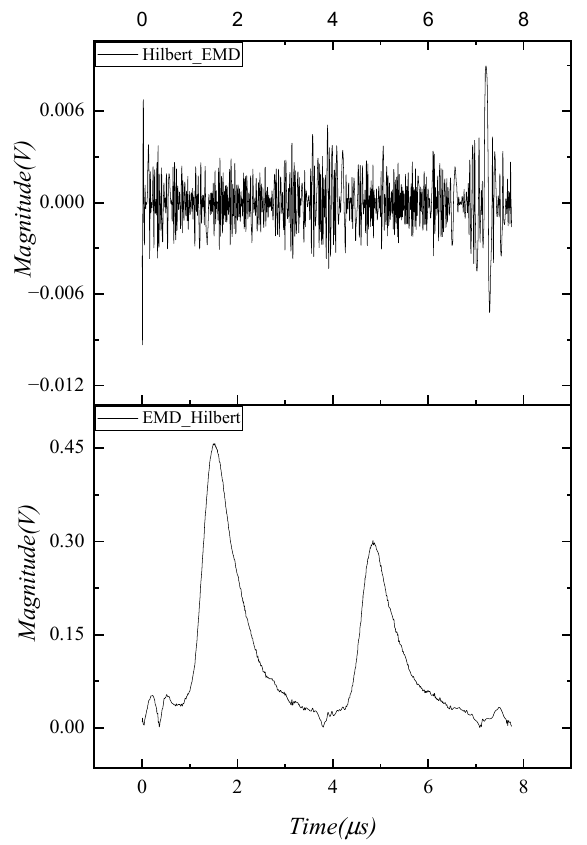
Figure 9. Comparison sequences of Hilbert_EMD and EMD_Hilbert for signal processing.